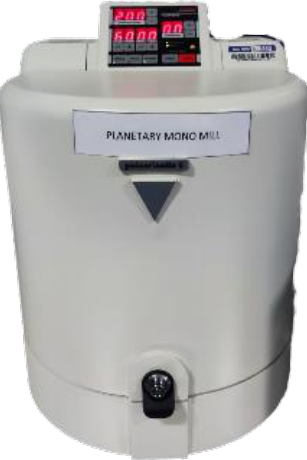
Figure 3. Planetary Mono Mill Pulverisette 6 can be used in the ball mill